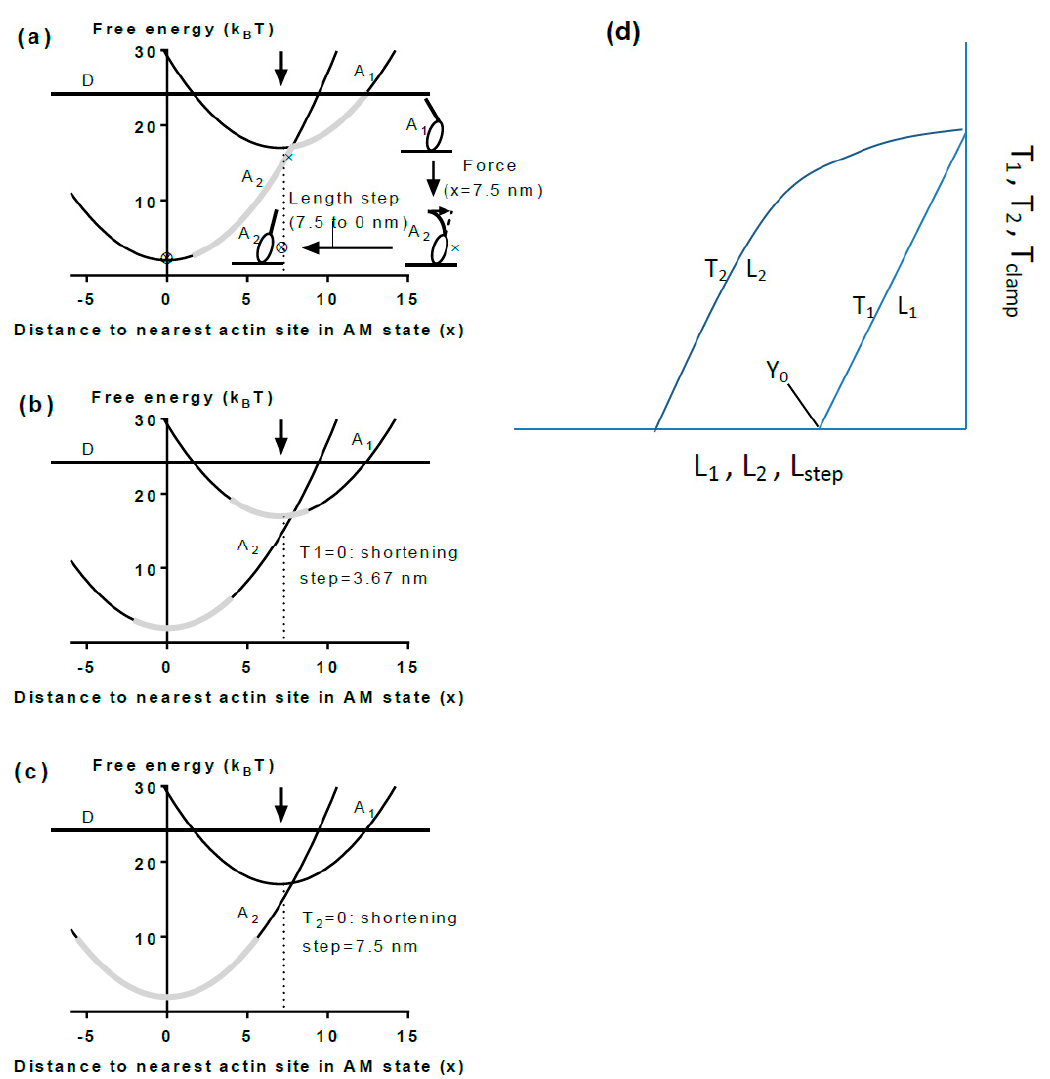
Figure 6. Simplified tentative cross-bridge model and details of muscle mechanical experiments for analyzing model. ( a ) Free energy diagrams for one detached cross-bridge state (straight horizontal line at 25 k B T; state D) and two attached cross-bridge states, a pre-power-stroke state A 1 and a post-power-stroke state A 2 . The free energy values are given as function of the variable x, reflecting the distance of the myosin head from the nearest binding site on actin, Definition of x = 0: free energy minimum and zero force in state A 2 . Arrow indicates mean position for attachment into state A 1 from the detached state. Grey areas on free energy diagrams indicate range over which different states may be populated in a muscle during isometric contraction. Inset: Schematic structural changes associated with length step (power-stroke) and isometric tension development (tensing step); ( b ) Same diagram as in ( a ) but indicating cross-bridge distribution in muscle (grey area) after a shortening step that brings tension to zero; ( c ) Same diagram as in ( a , b ) but displaying the cross-bridge distribution after rapid recovery subsequent to length step (mentioned in ( b )) or after rapid shortening during phase 2 of a load-clamp from isometric force to zero force; ( d ) Schematic plots of T 1 and T 2 (see Figure 4) against the imposed length changes. Note similar relationships between T 1 and T 2 and the imposed length steps (L step ) and between the imposed loads (T clamp ) in the load clamps and the recorded length changes L 1 and L 2 (cf. [173]).